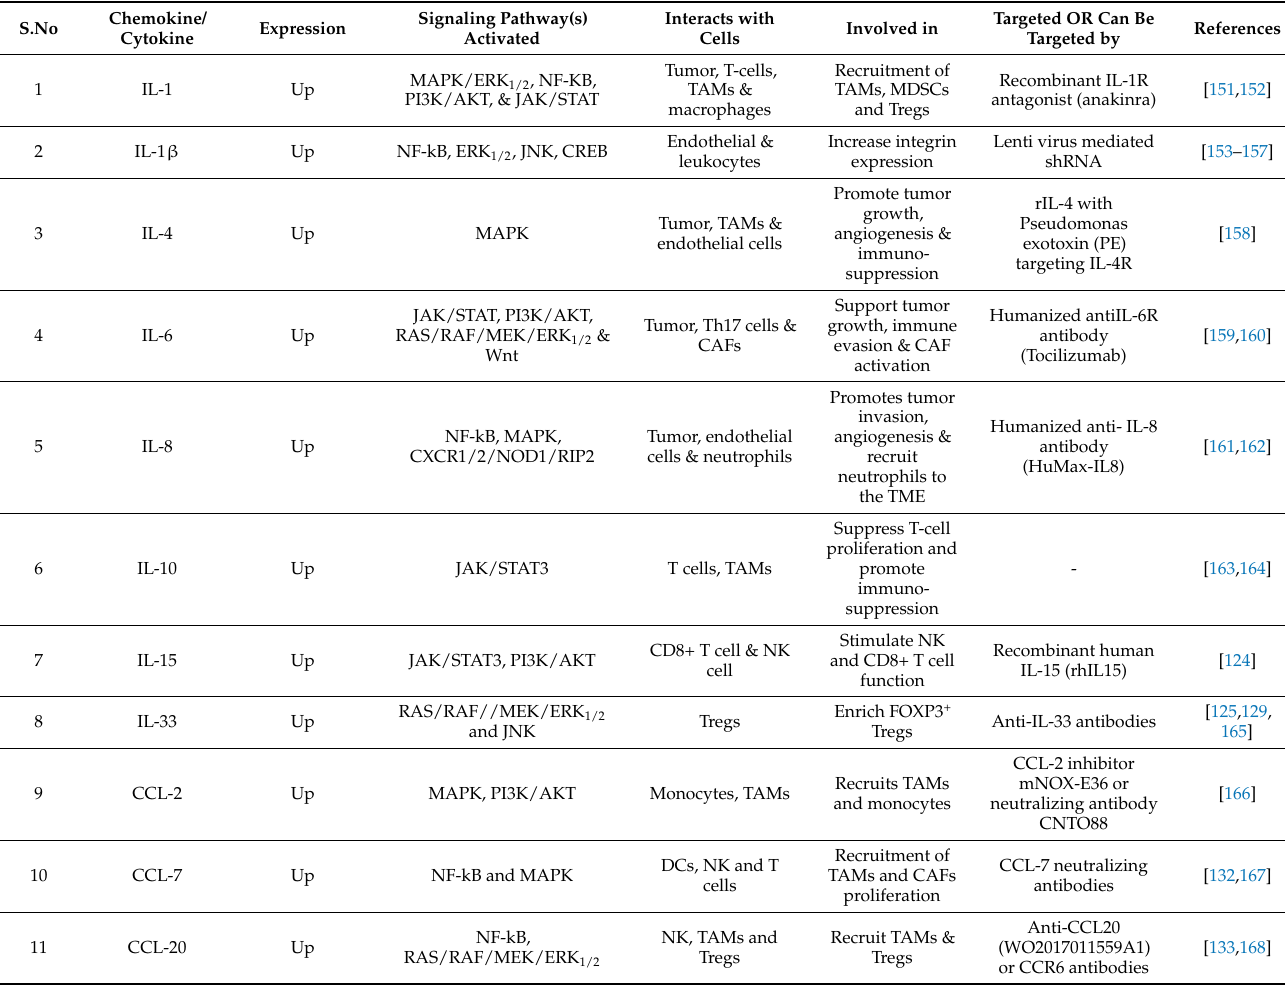
Table 1. Deregulated Chemokines/Cytokines and their Therapeutic Targeting in